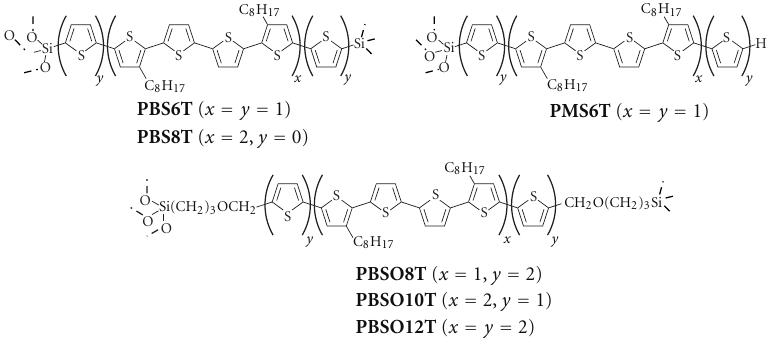
Figure 1: Chemical structures of PSQs having